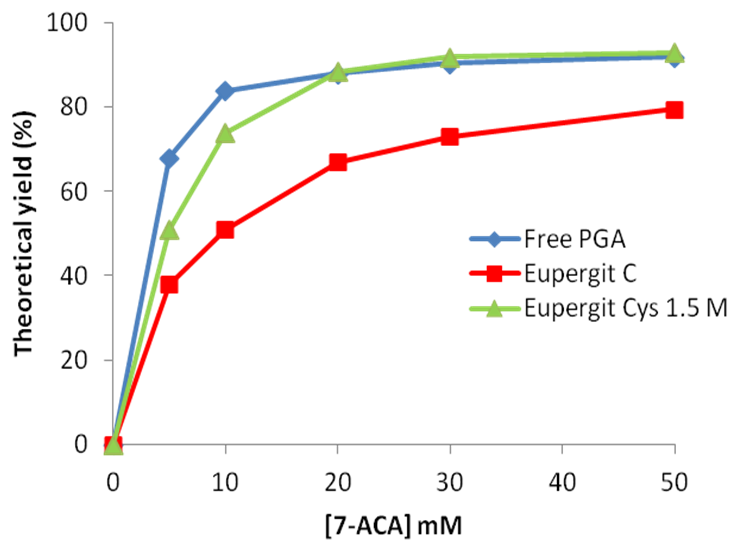
Reaction conditions : 4 °C, pH 6.5, R -( − )-methyl mandelic ester: 5 mM. Theoretical yield was calculated as following: (vs/vs + vh ) × 100 (see 1